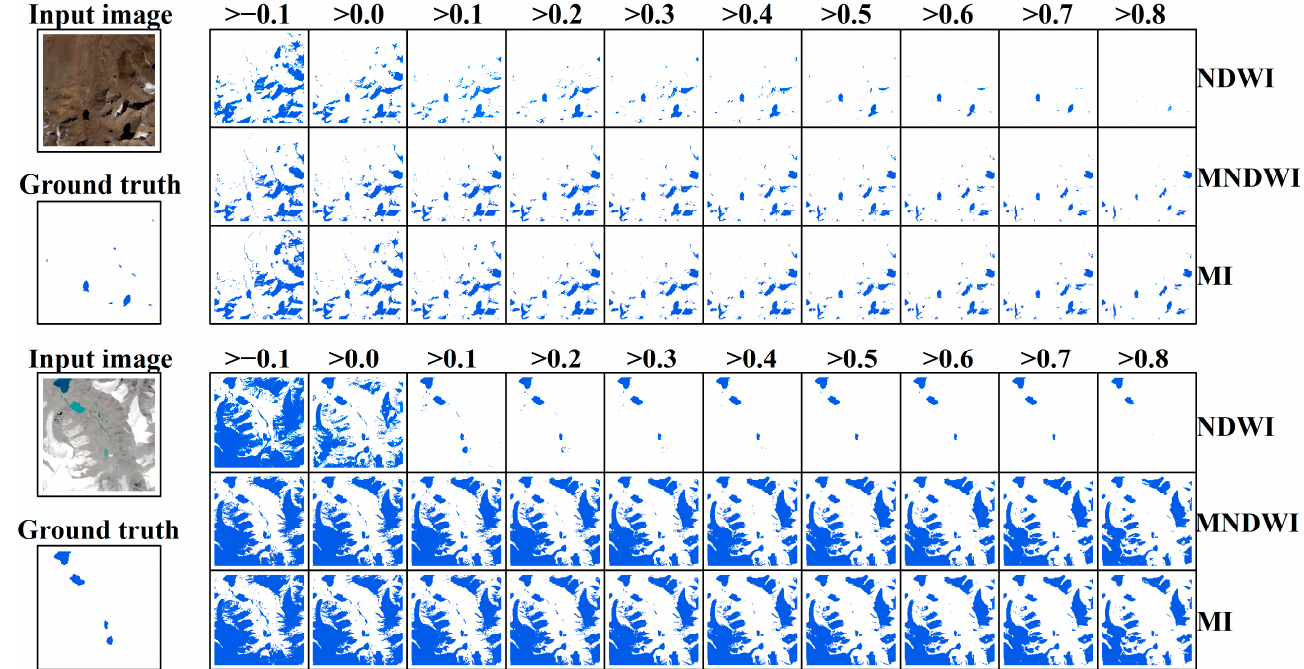
Figure 6. Two visualized samples of SimGL when setting different thresholds and WIs in the pseudo label generation stage. The blue area is lakes extracted by SimGL. From visualizations, the model output is closest to the ground truth when we set the threshold in the range of [0.5, 0.7] on NDWI. Table 3. Evolution results of different types of image